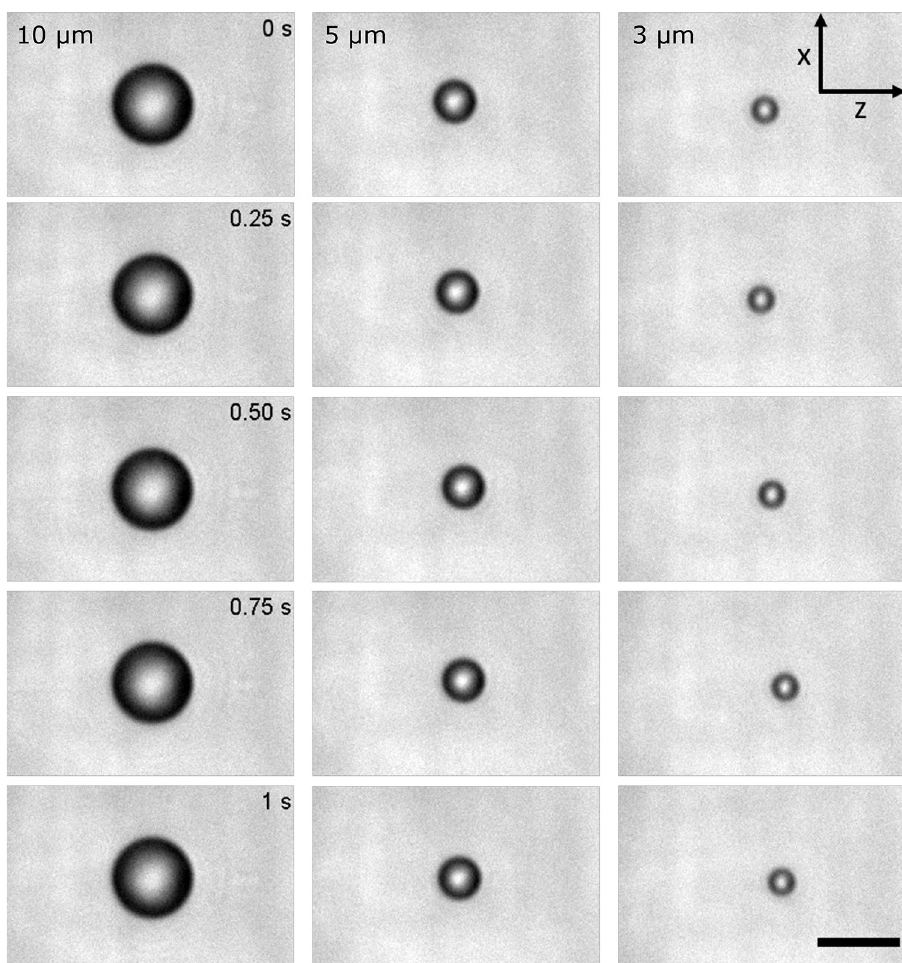
Figure 3. (Left to right) Images of 10 µ m , 5 µ m and 3 µ m optically trapped particles at different time points using laser power ( P ) = 200 mW from each optical fiber. Especially for 3 µ m particle, position fluctuations within the 1 s recording duration can be observed. Scale bar is 10